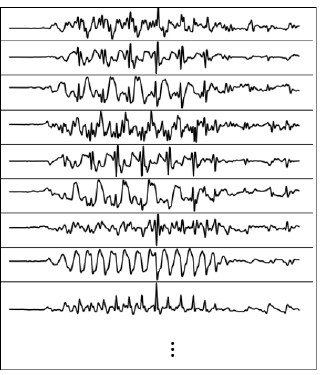
Figure 12. 2DCNN combined logic.